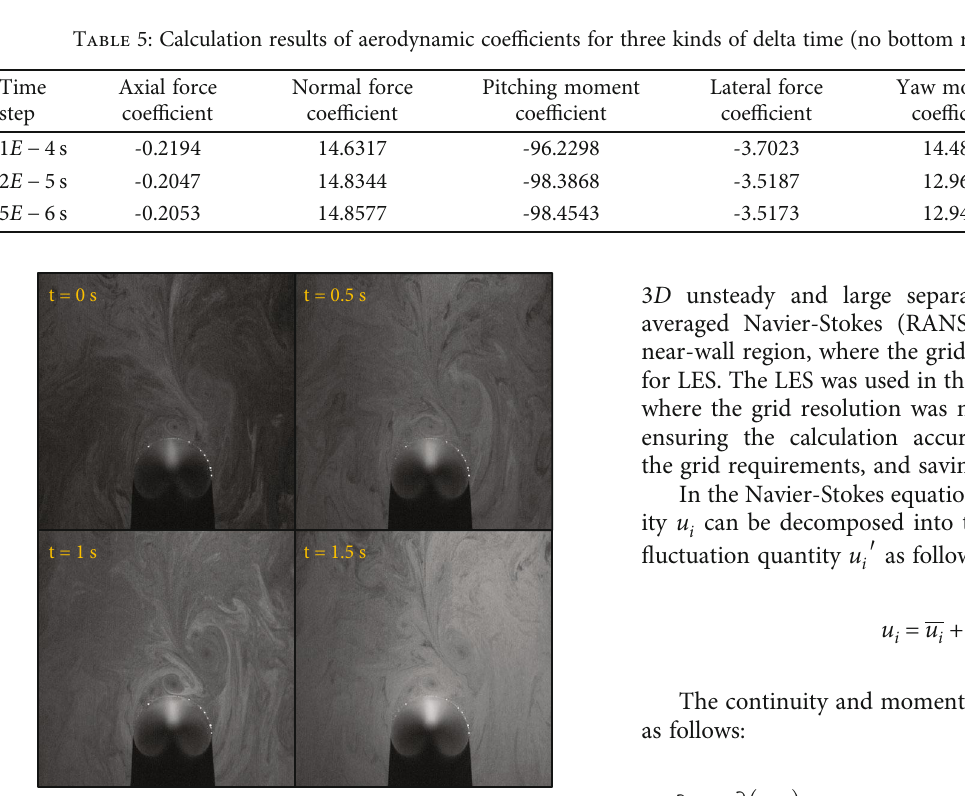
Figure 13: Flow structure is steady with time increase.